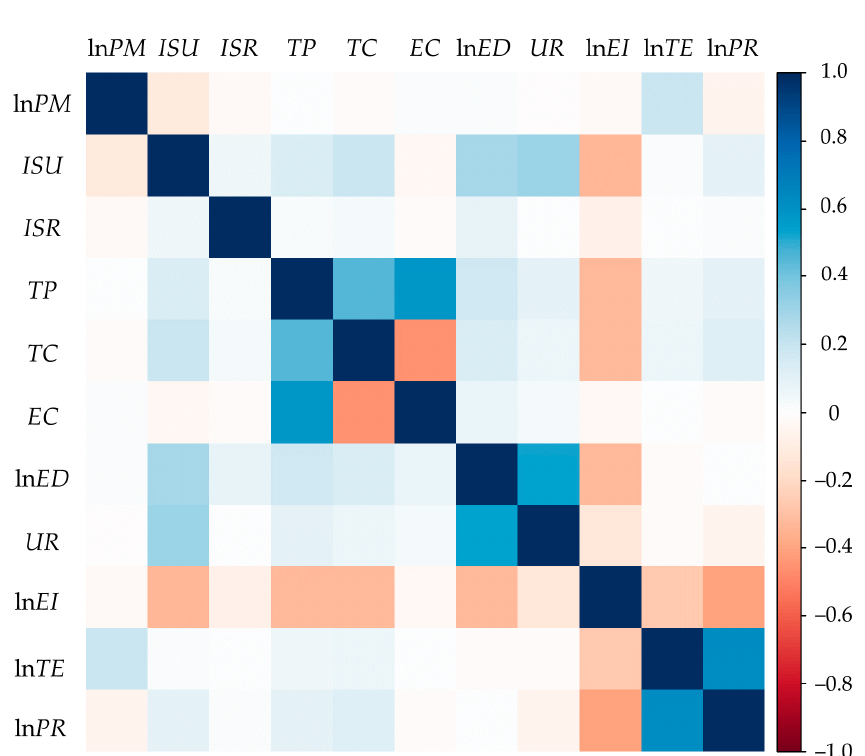
Figure 1. Correlation test results for the model variables.